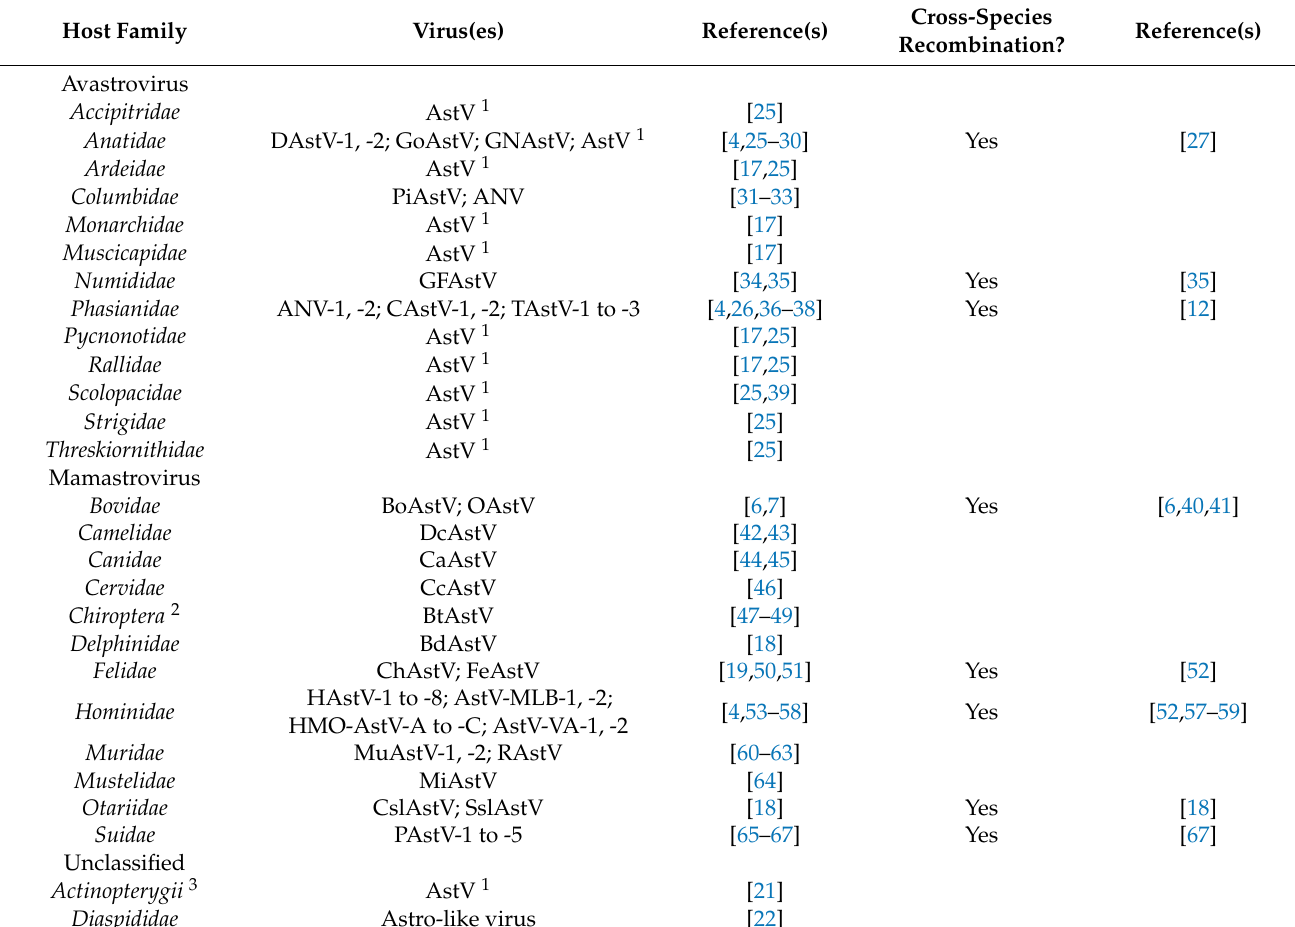
Table 1. Avian, mammalian, and unclassified astroviruses by host family and evidence for cross-species